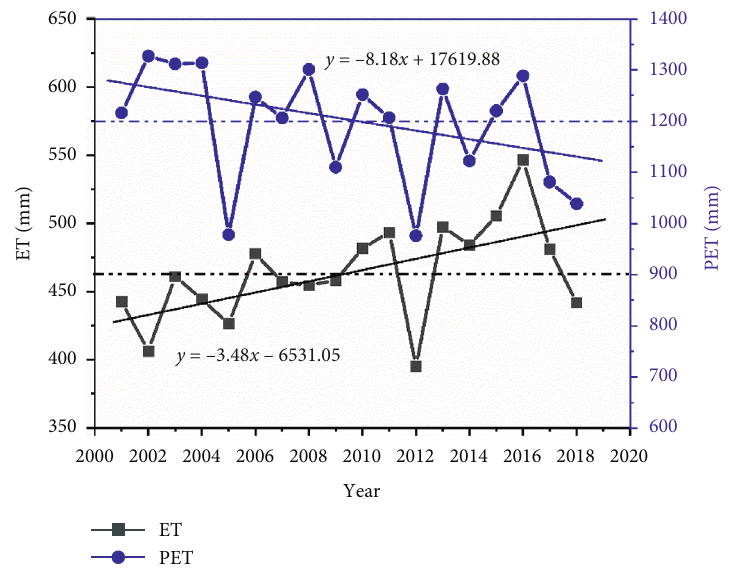
Figure 5: Temporal changes of annual ET and PET in the upper Taohe River basin during